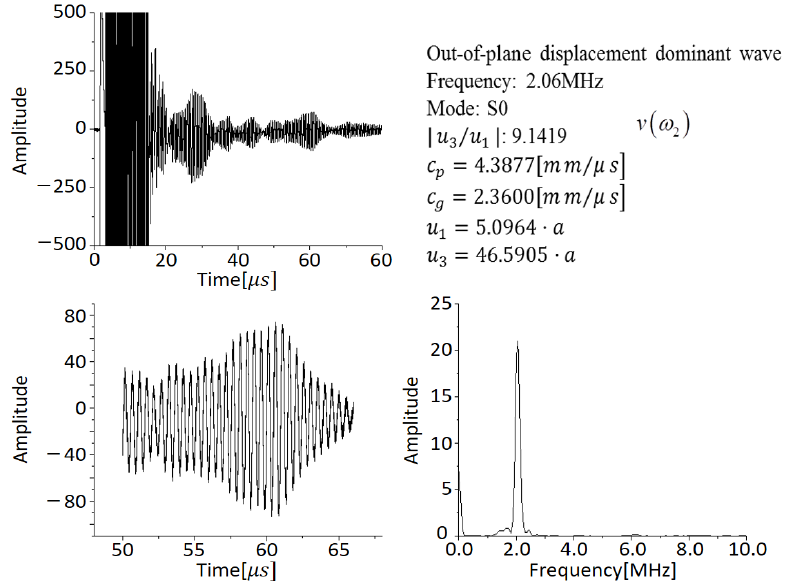
Figure 10. Wave velocity and frequency analysis for 2.06 MHz (S0 mode).